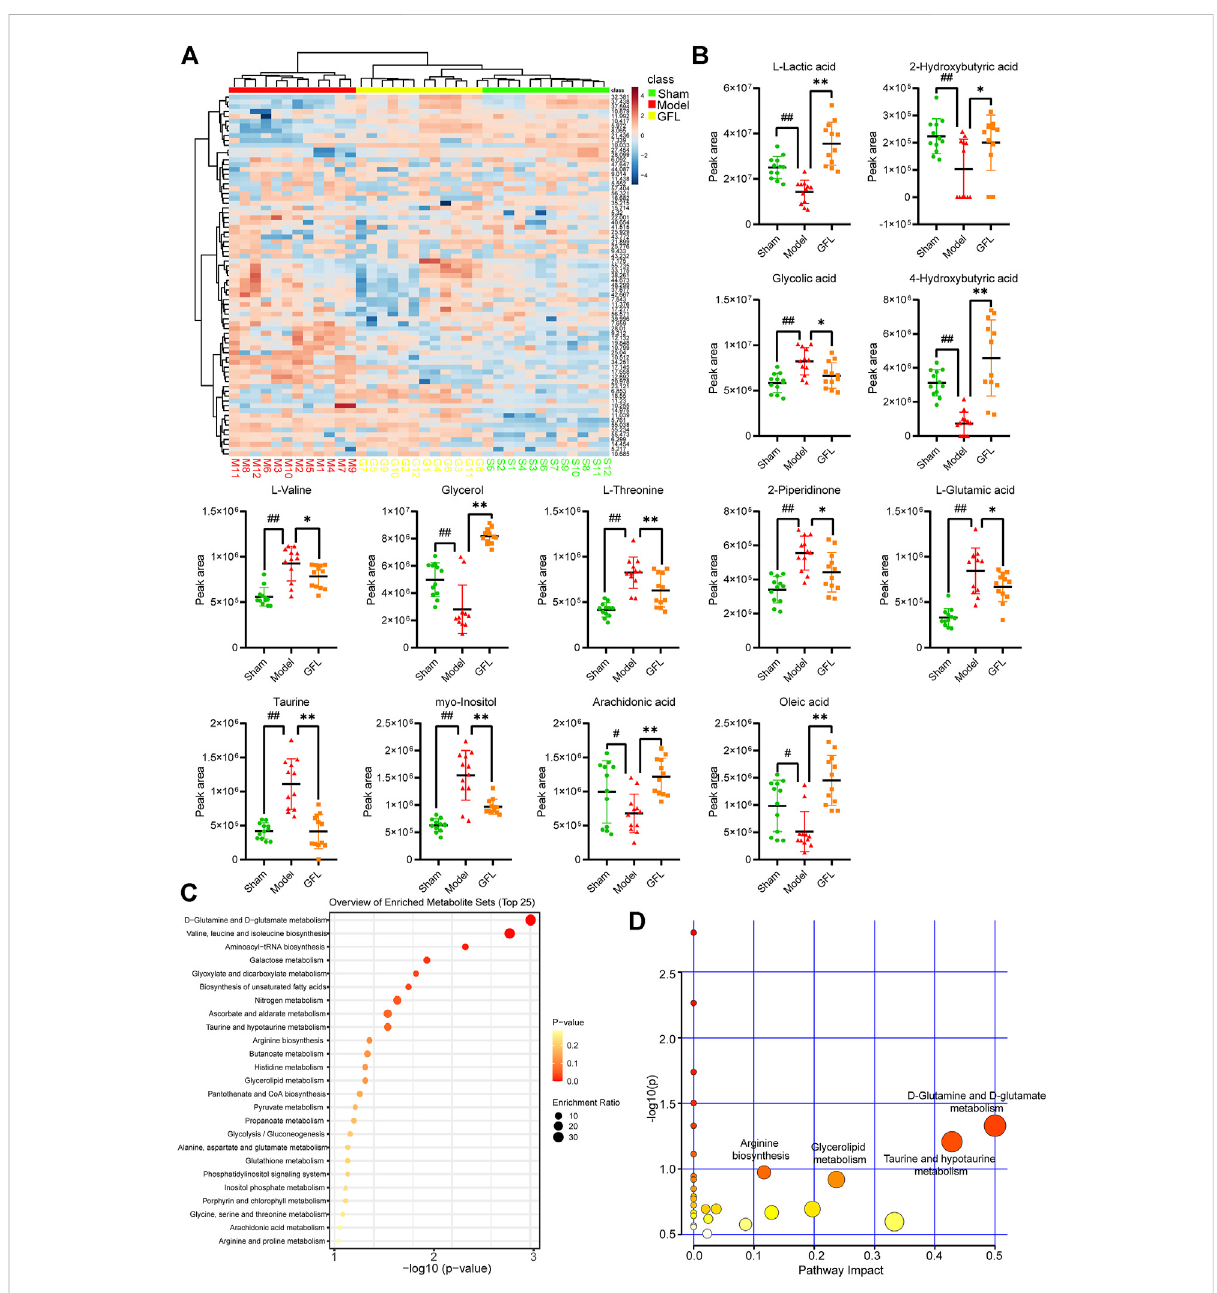
FIGURE 5 Data analysis of GC-MS endogenous metabolites. (A) Heat map of serum metabolic related to hepatic fi brosis induced by GFL in each group of mice. Color represents the concentration of metabolites, from low (blue) to high (red). Green represents a fake surgical group, red represents the model group, and yellow represents the GFL group. (B) Peak area of differential metabolites. (C) Enrichment analysis of differential metabolites. (D) Pathways analysis of differential metabolites. Data are expressed as the mean ± SD, n = 12. Data were analyzed using one-way ANOVA. # p < 0.05, ## p < 0.01 compared to the sham group. * p < 0.05, ** p < 0.01 compared to the model